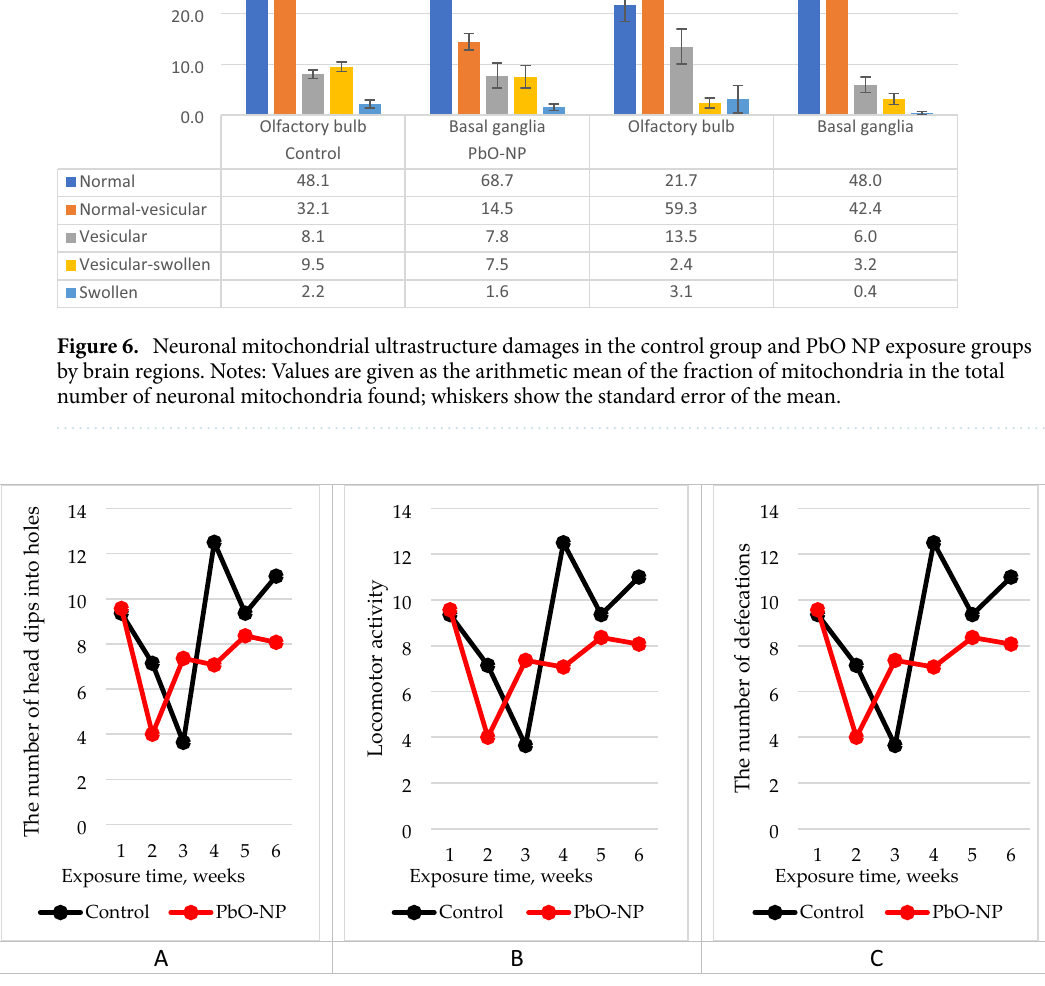
Figure 7. Results of the open field test of the experimental animals: ( A ) the number of head dips into holes; ( B ) locomotor activity; ( C ) the number of defecations. The abscissa shows the exposure time in weeks, the ordinate shows the magnitude of